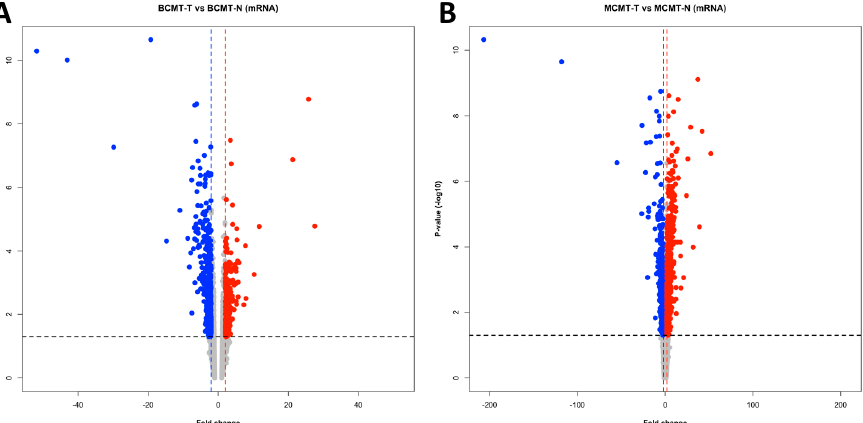
Figure 5. Volcano plot in canine mammary gland tumor for mRNA. Red dots indicate upregulation, blue dots indicate downregulation and grey dots indicate unsignificant miRNAs. Red and blue dotted line are threshold of fold change and black dotted line is threshold of p -value. ( A ) BCMT-T vs. BCMT-N; ( B ) MCMT-T vs. MCMT-N.